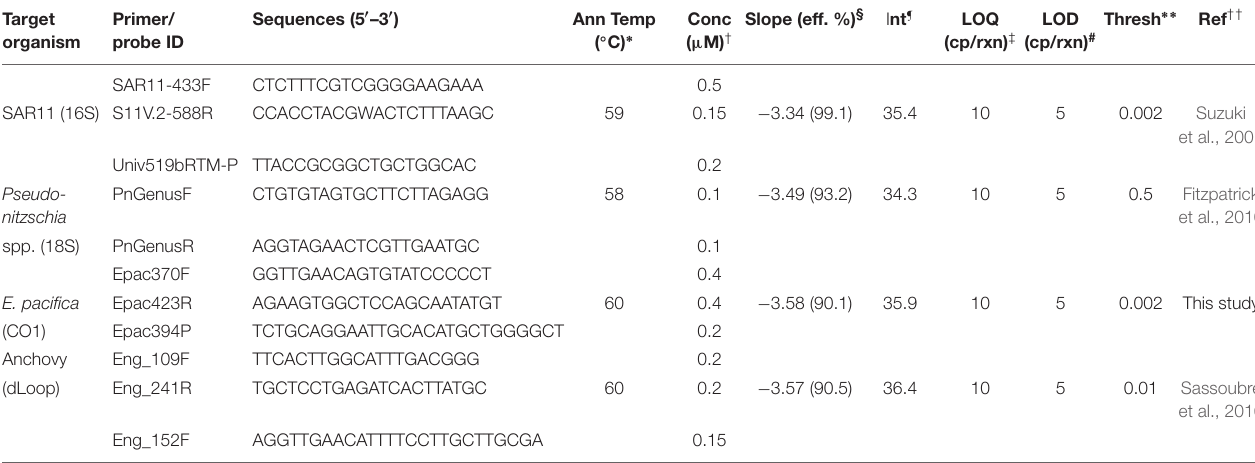
TABLE 1 | qPCR chemistries, condition and standard curve